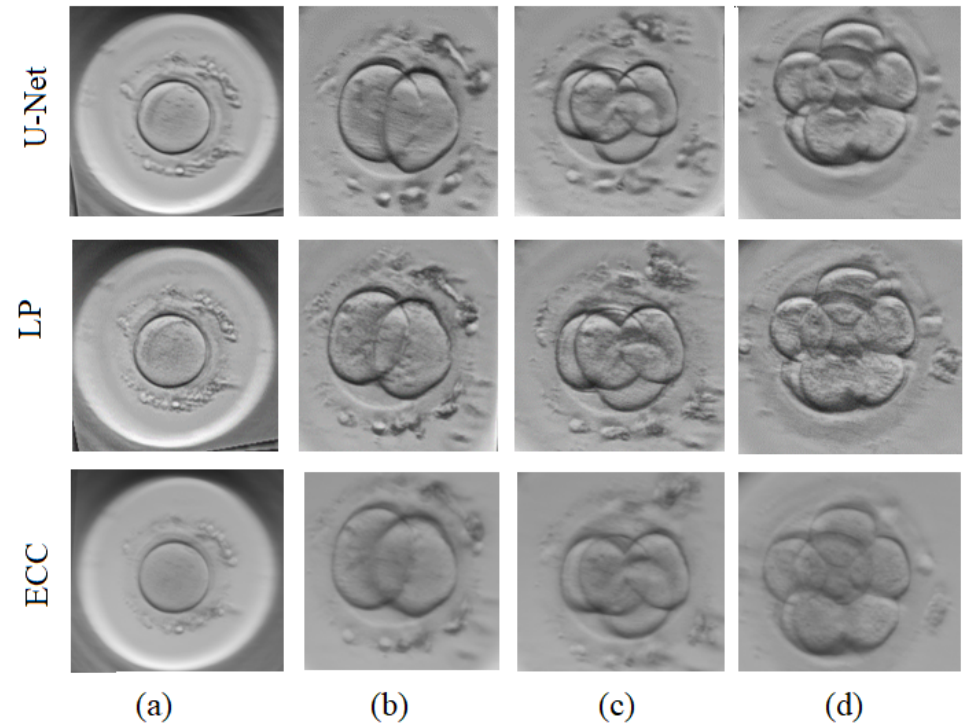
Figure 7. Fused embryo images using U-Net, Laplacian pyramids (LP) and Enhanced Correlation Coefficient (ECC)